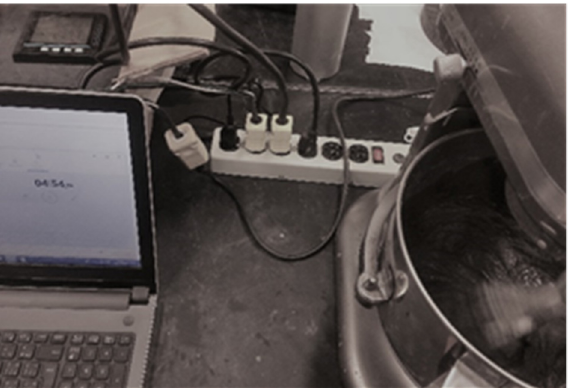
Figure 1. Installation for recording the power consumed by a laboratory mixer during the preparation of CPB mixtures.